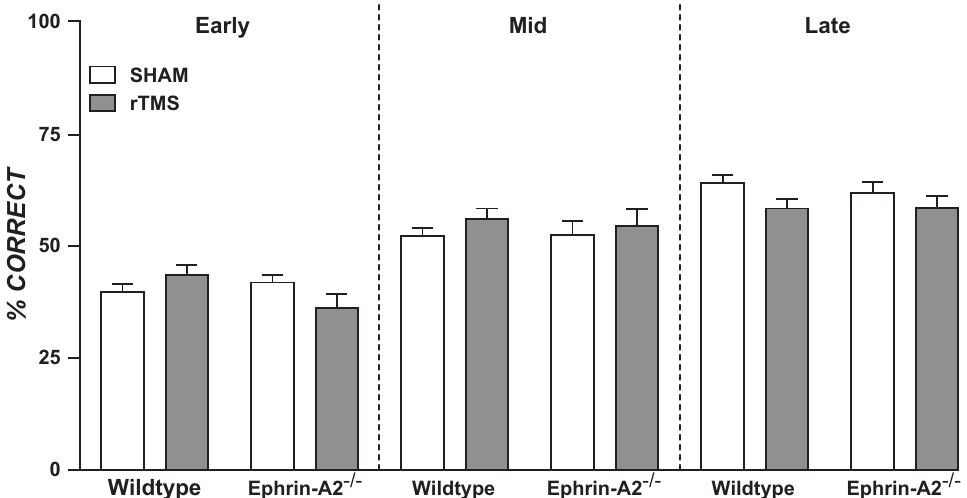
Figure 1. Mean percentage correct in a reverse-learning task for wildtype and ephrin-A2 -/- mice receiving daily rTMS. Early, middle (mid) and late blocks were delineated by the first, second and final third of total number of days training in the reverse-learning task. Within groups, scores increased significantly between blocks ( p <0.001), but there were no significant differences between rTMS and sham or between genotypes ( p values >0.05; ANOVA). Error bars =